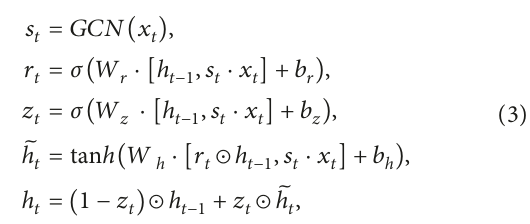
Figure 2: The left image is the framework of ST-DWGRU, where V DWGRU